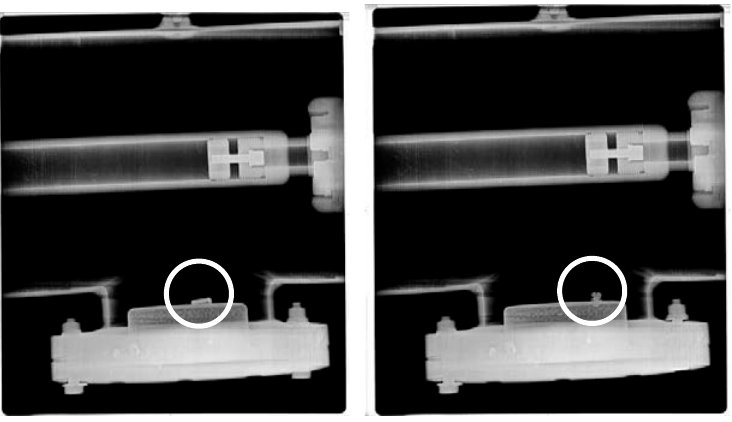
Figure 15. Foreign bodies in the particle trap.